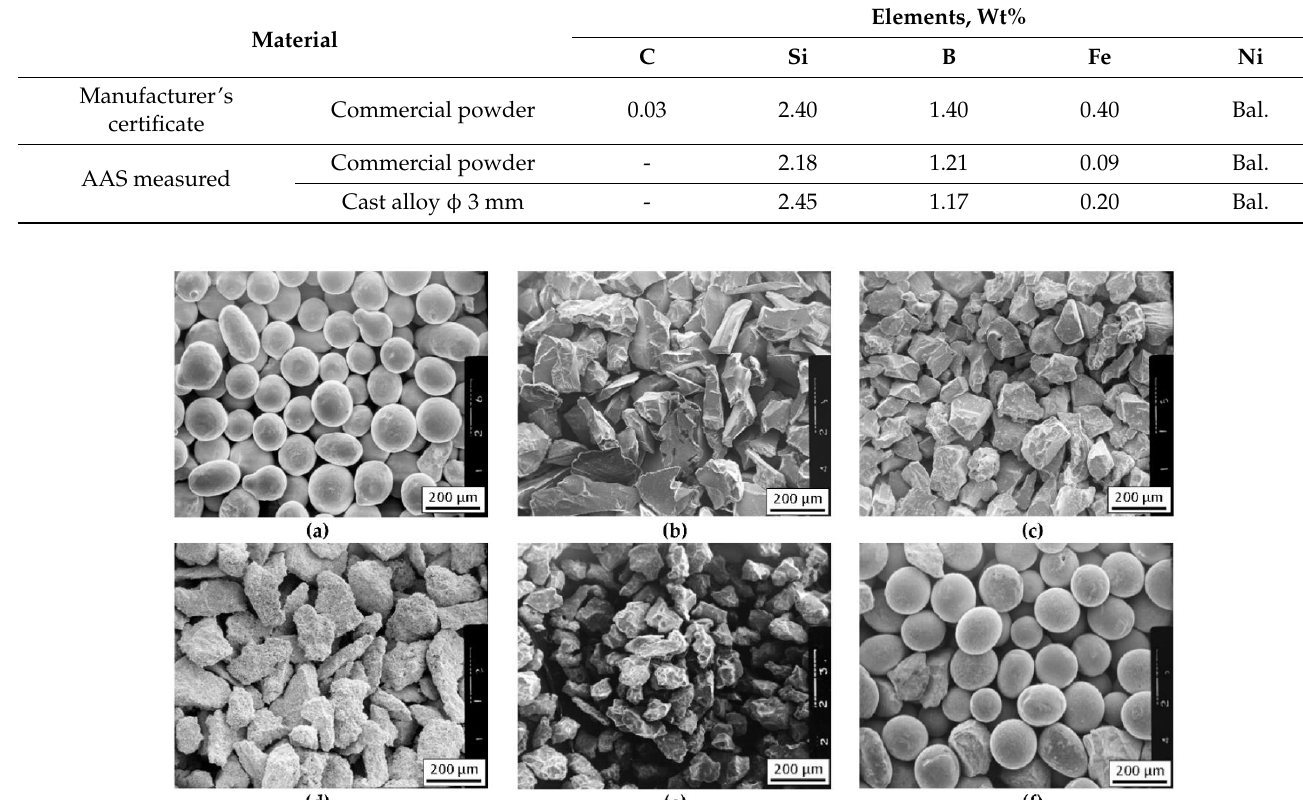
Figure 1. The morphology of powders for the production of composite layers using the plasma surfacing method: ( a ) NiBSi, ( b ) TiC, ( c ) ZrC, ( d ) Cr 3 C 2 , ( e ) Mo 2 C, and ( f ) WC.